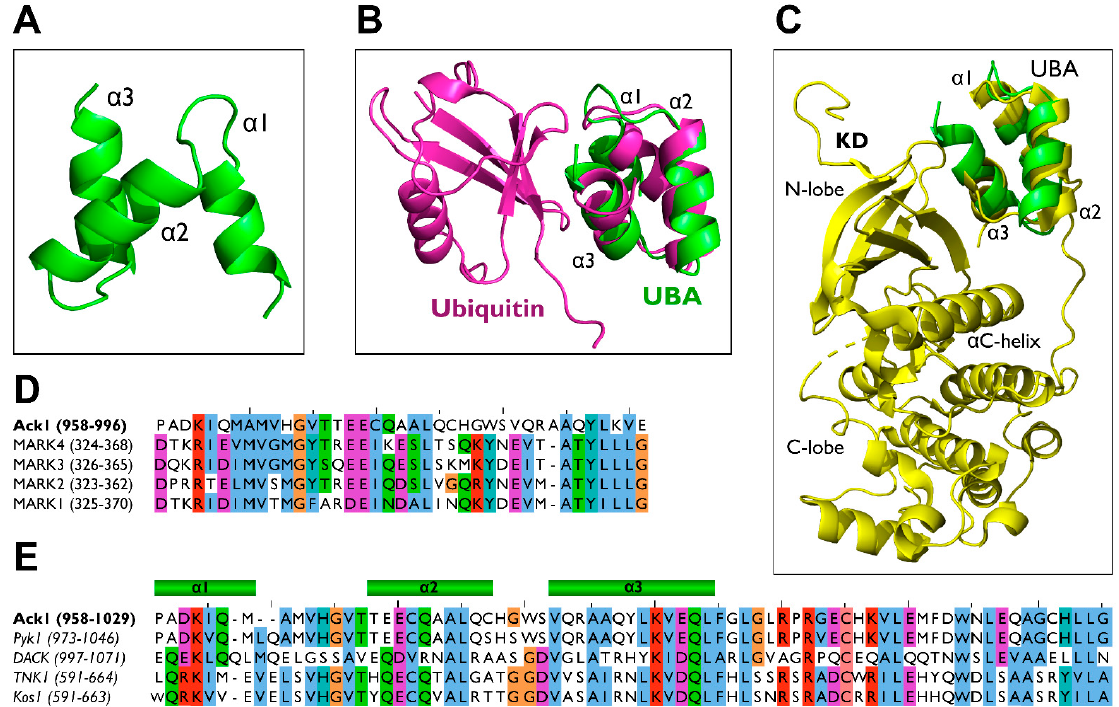
Figure 14. Ack1 UBA domain homology modeling. ( A ) Ack1 UBA domain structure predicted by AlphaFold [86,87] represented in a ribbon diagram ( B ) Structural alignment of predicted Ack1 UBA domain (green) and the yeast Ede1 UBA-ubiquitin complex (PDB: 2G3Q, magenta) ( C ) Structural alignment of predicted Ack1 UBA (green) and MARK3 UBA-KD complex (PDB: 2QNJ, yellow). ( D ) Multiple sequence alignment of the UBA domains of the human Ack1 UBA and MARK